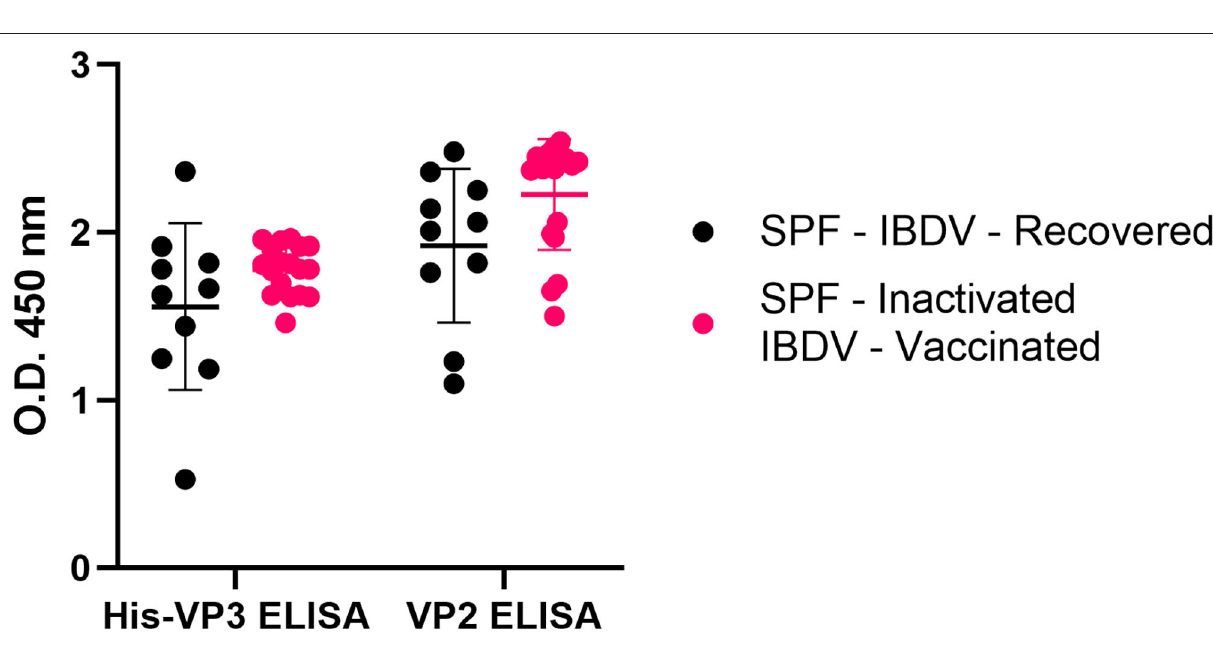
FIGURE 6 | The His-VP3-based ELISA allows the identification of chicken infected or vaccinated with inactivated IBDV vaccines. Distribution of O.D. 450 values of post-challenge WL SPF chickens sera (SPF- IBDV-recovered, black; SPF-inactivated IBDV vaccinated, pink) analyzed with His-VP3 and ID Screen® IBD VP2 ELISA. Horizontal and vertical bars: mean ± standard deviation